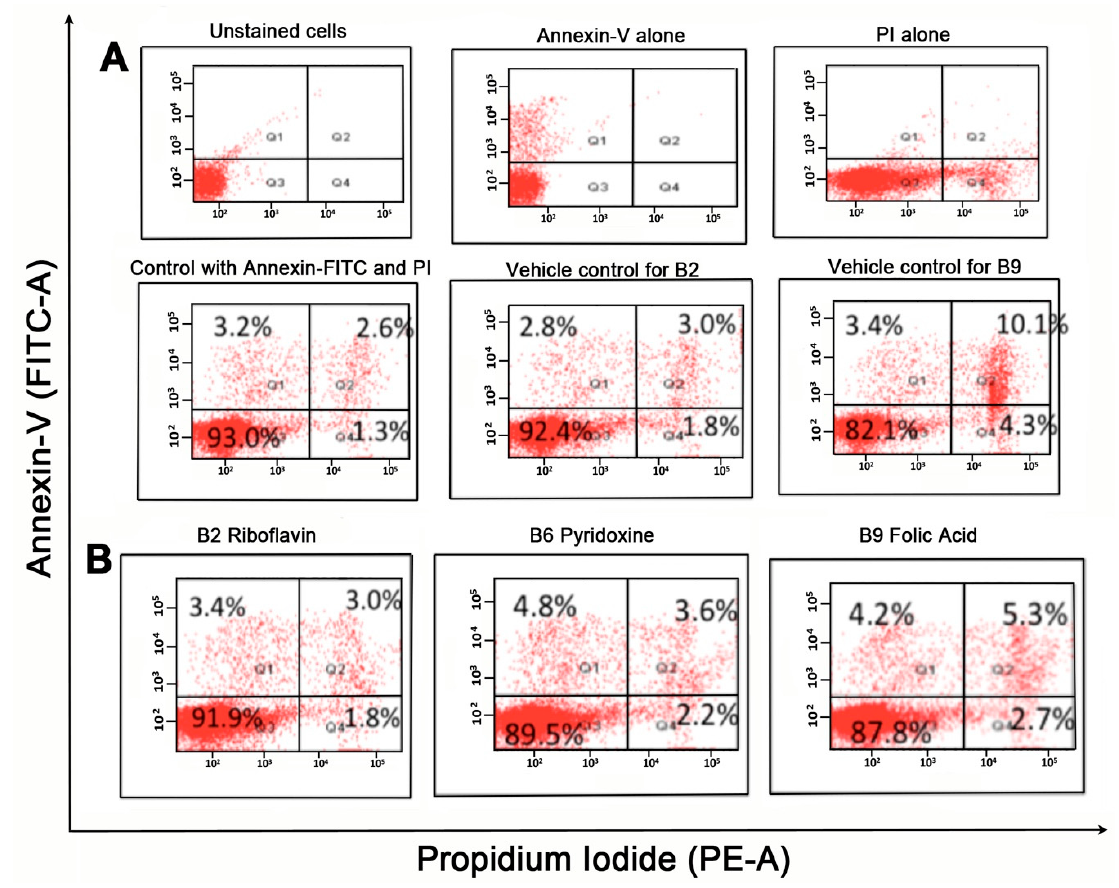
Figure 2. Annexin V-FITC/propridium iodide (PI) staining of undifferentiated U937 cells incubated with vitamin B . 1 × 10 6 of U937 cells treated with 0.25 μ g/mL of B2 and 250 μ g/mL of vitamin B6 and